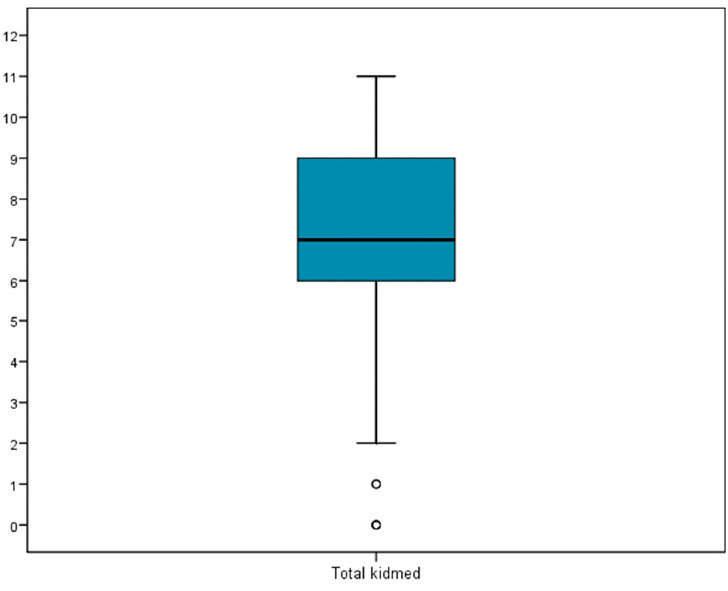
Figure 2. Distribution of KIDMED questionnaire values.